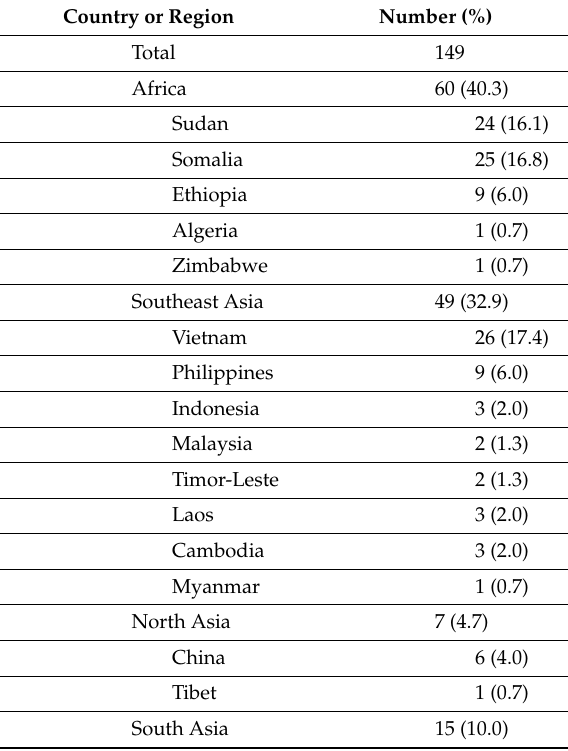
Table 2. Ethnic identification or country of birth of parent from 2009 to